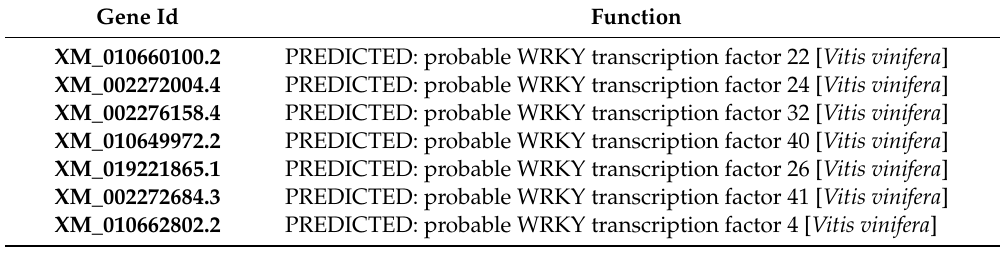
Table 2. Putative transcription factors in yeast one-hybrid screening analysis.